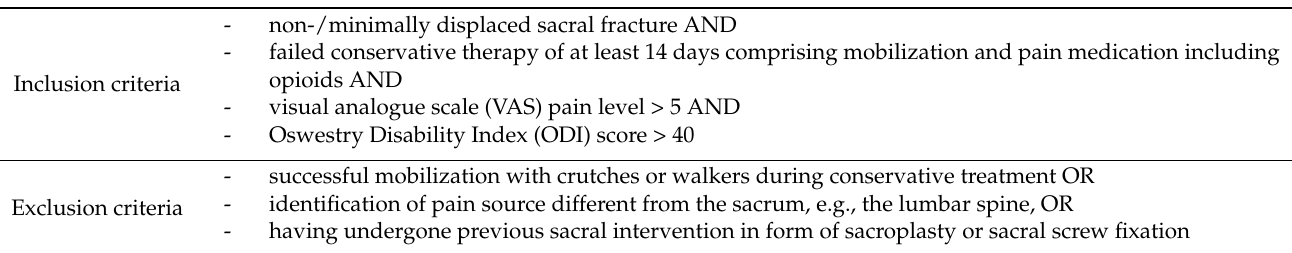
Table 1. Inclusion and exclusion criteria of the